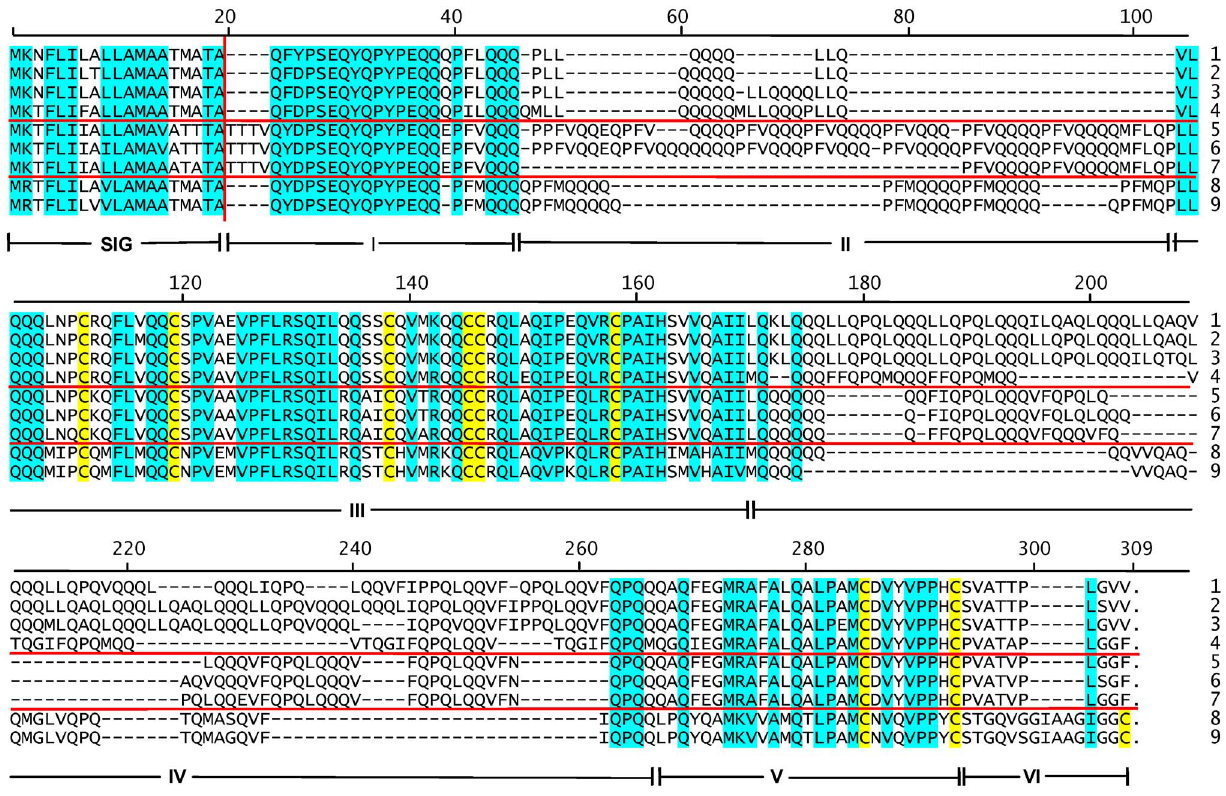
Figure 1. Alignment of avenin amino acid sequences. The derived amino acid sequences of the nine cv CDC Dancer avenins are aligned with ClustalW. Positions within the total alignment are noted above the sequences. Domains of the polypeptides are indicated below the sequences in Roman numerals. Amino acid residue positions conserved in all nine sequences are shaded blue. Conservation being defined as the same amino acid or amino acids with similar characteristics; i.e., D/E, F/Y, K/R, L/I/V/A, S/T. Cysteine residues are shaded yellow. Horizontal red lines separate major subclasses. The vertical red line indicates the site of cleavage of the signal peptide during post-translational processing.